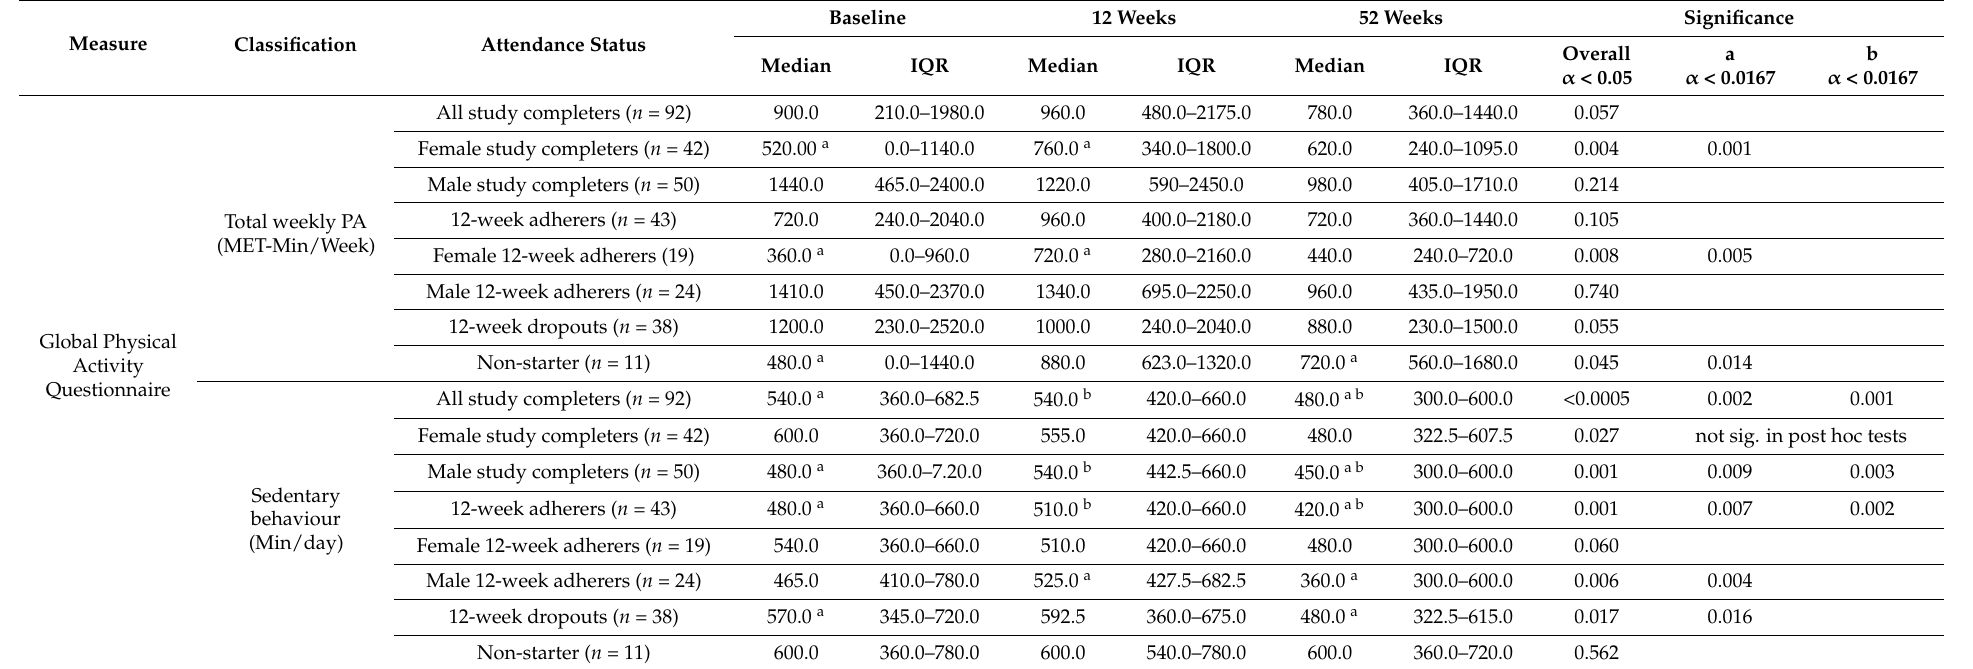
Table 6. Study completers: change in physical activity and sedentary